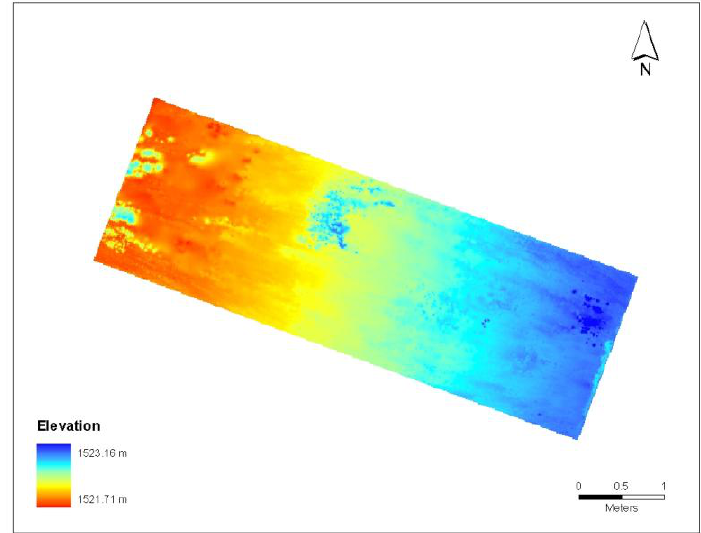
Figure 4. DSM created from XYZ point cloud data collected from ground-based LiDAR